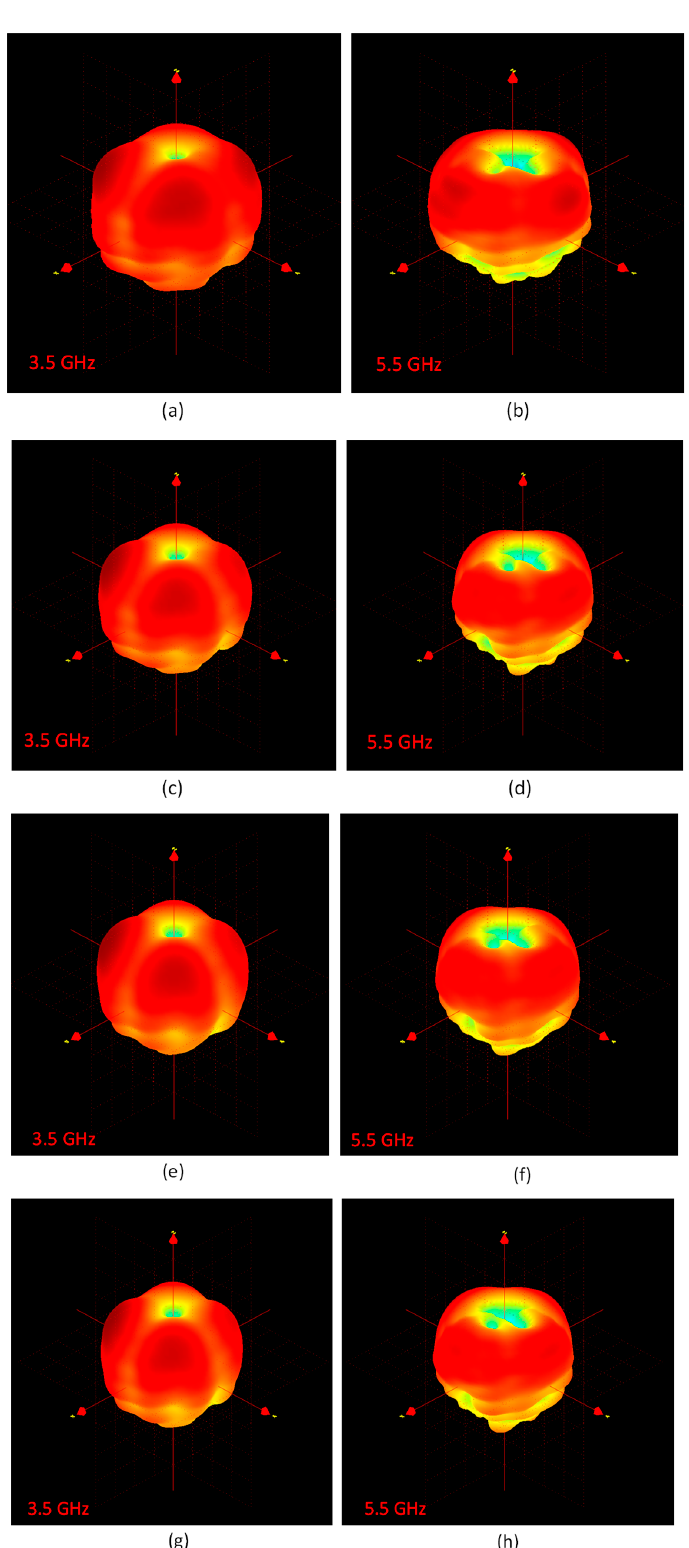
Figure 7. 3D radiation patterns: monopole at ( a ) 3.5 GHz and ( b ) 5.5 GHz; DRA1 at ( c ) 3.5 GHz and ( d ) 5.5 GHz; DRA2 at ( e ) 3.5 GHz and ( f ) 5.5 GHz; DRA3 at ( g ) 3.5 GHz and ( h ) 5.5 GHz.